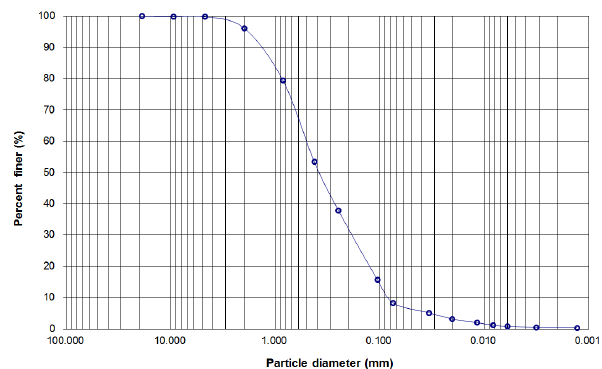
Figure 3. Grain size distribution of the weathered granite